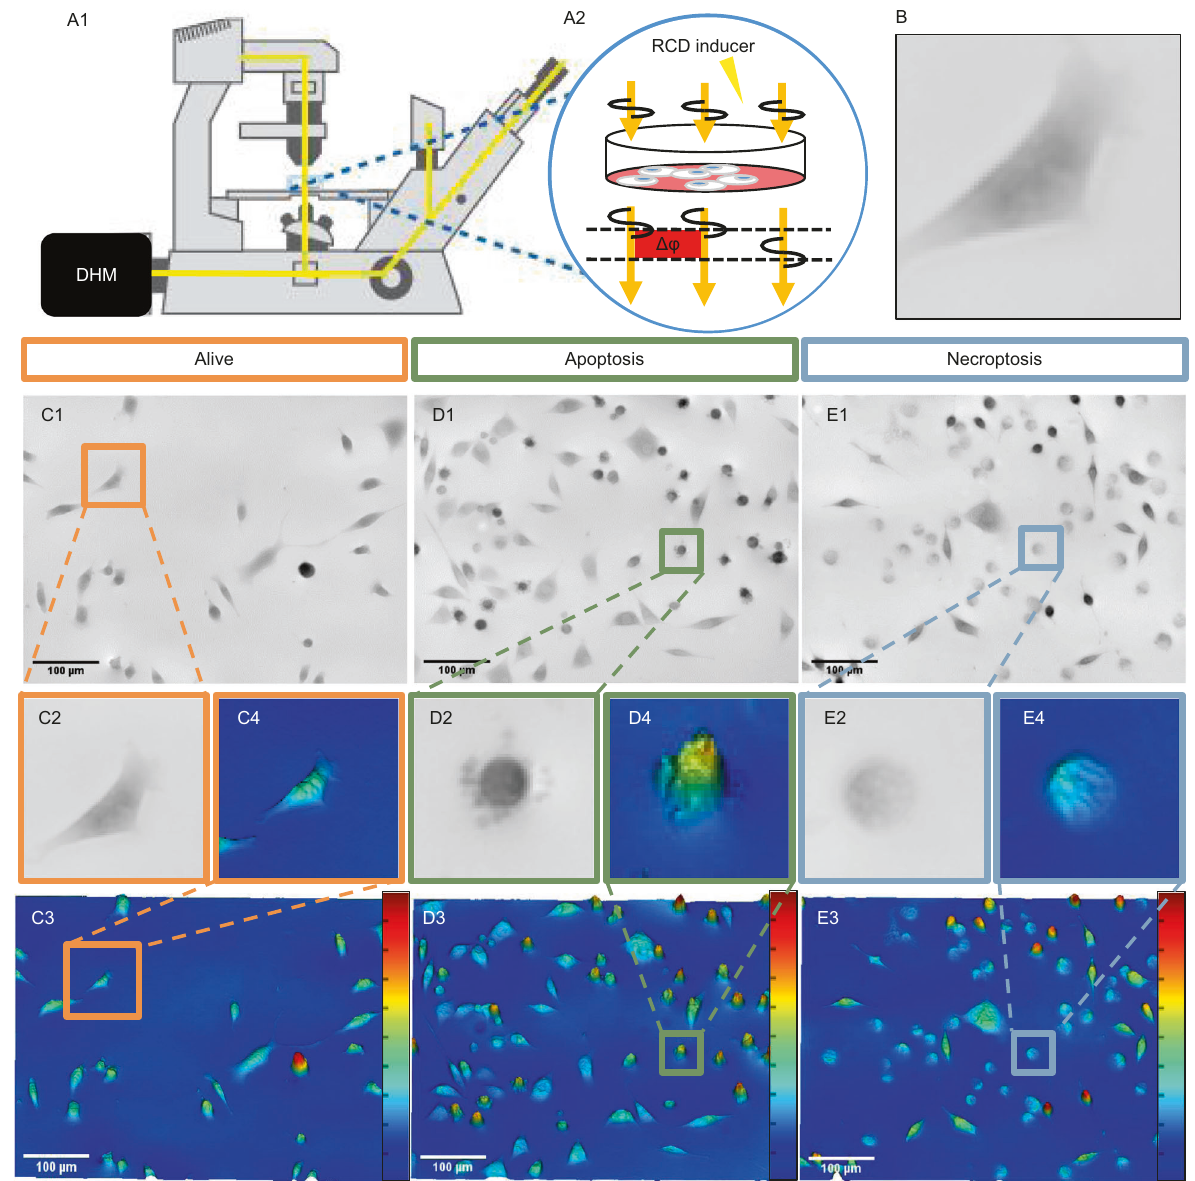
Fig. 2 The application of digital holographic microscopy on regulated cell death. A1 A schematic representation of the DHM setup. 5.5 ×104 cells/mL of L929sAhFas cells were grown in a glass bottom dish with a 15 mm glass coverslip and, depending on the experiment a cell death inducer was added. A2 Transmission light was applied in an inverted microscope setup. Light beams that interfered with cells resulted in a phase delay, which is quanti fi ed by the DHM camera and saved as a hologram. B An example of images used as input for the deep learning neural network. C1 – C4 Hologram images of alive cells (without any cell death inducer). C1 is the phase image of the complete fi eld of view, with C2 being a single cropped image from this capture. Images similar to C2 were used as input towards model development shown in Fig. 3B. C3 and C4 are 3D representations of the optical height from the holograms, with a relative scale bar (100 µm). C2 and C4 represent the same cell. D1 – D4 A similar layout as given for C1 – C4, however, cells are induced either to undergo apoptosis with 125 ng/mL of anti-Fas antibody. For E1 – E4 the cells were exposed to 100 ng/mL of mTNF to induce necroptosis. from the images [26]. Peculiarly, this is in contrast to classical from an image (white and red boxes Fig. 3B), coupled with a fully machine learning applications [39]. With an appropriate analysis connected neural network to produce a prediction (blue and pipeline, the potential of deep learning can be applied. Where, green boxes in Fig. 3B) [40]. fi rst of all, the cells are extracted from the captures (Fig. 2B), To avoid potential phototoxicity of fl uorescent markers, we followed by pre- fi ltering using a SAD (Fig. 3A) and, lastly, a model have explored the capabilities of DHM, combined with deep is trained to classify the cells accordingly (Fig. 4A). Once the learning as a label-free detection method based on quantifying training is fi nalized, the holdout data set is applied on the the phase delay created by transparent objects, e.g., cancer cells. constructed model, in order to validate it (Fig. 4B). The presented In our work, we describe that a convolutional neural network is an approach yields a reliable method for prediction of regulated cell excellent approach for processing biological images in prediction death with a remarkable accuracy of 87.9%, 81.8% and 91.1% for purposes, since it does not rely on a pipeline to extract features